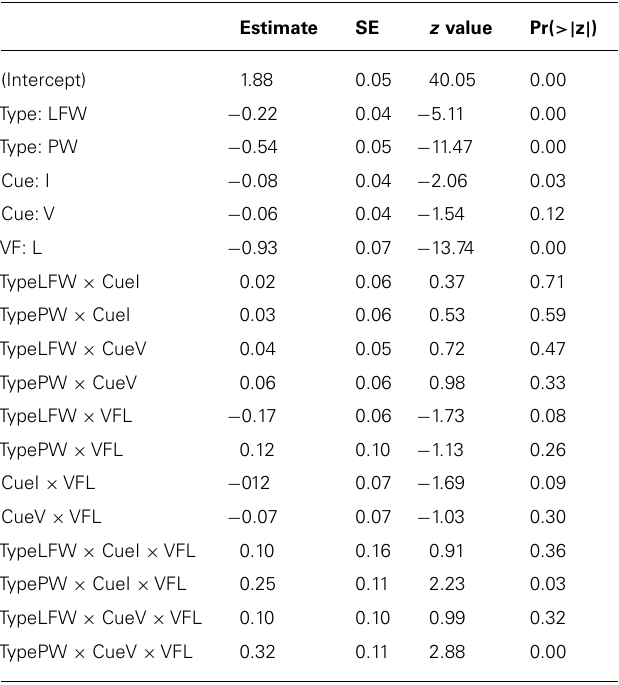
Table 3 | Fixed effects of the final model.